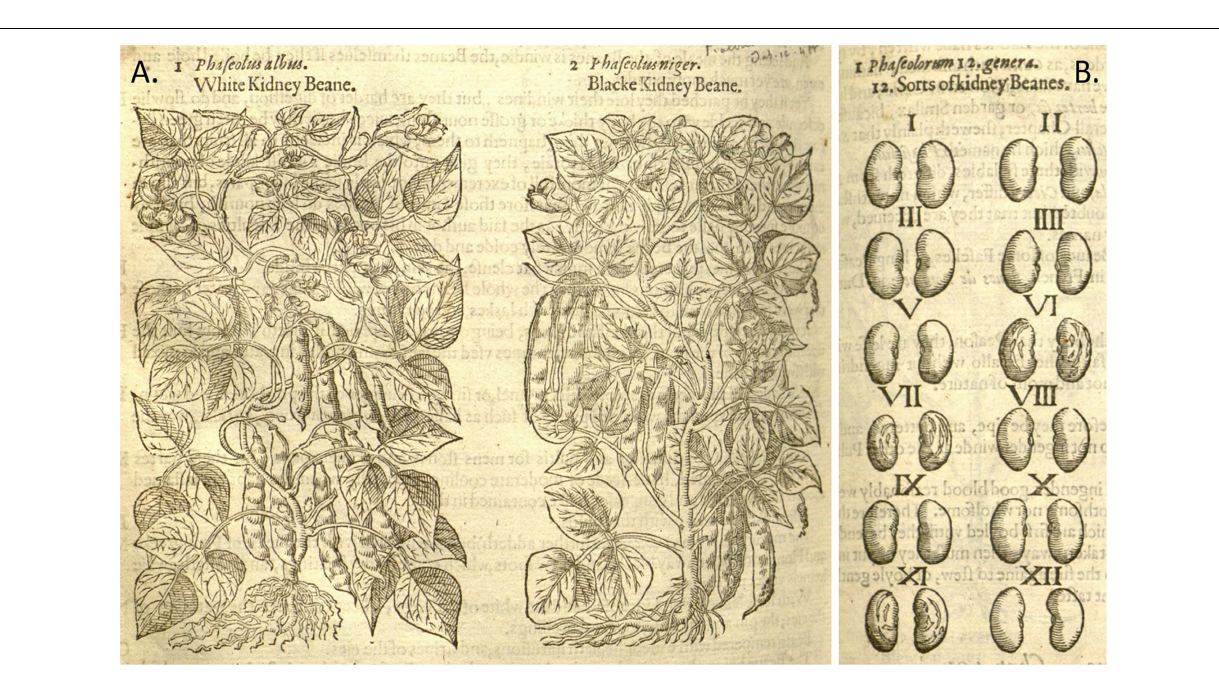
Frontiers in Plant Science |